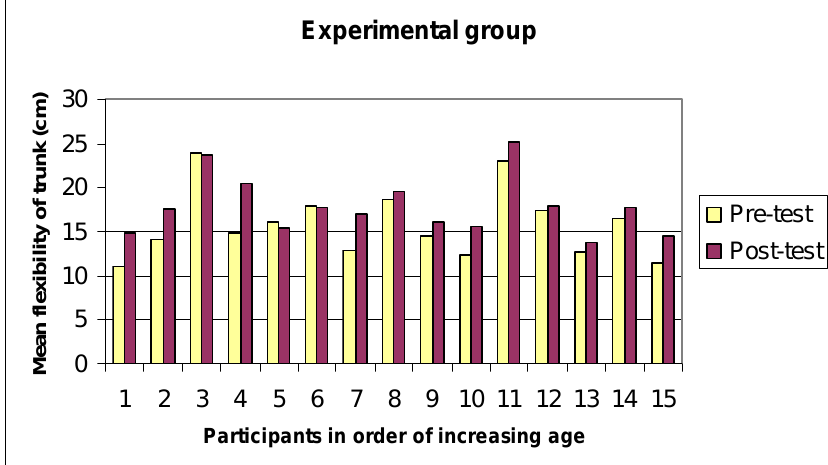
Figure 3. The results of the experimental group